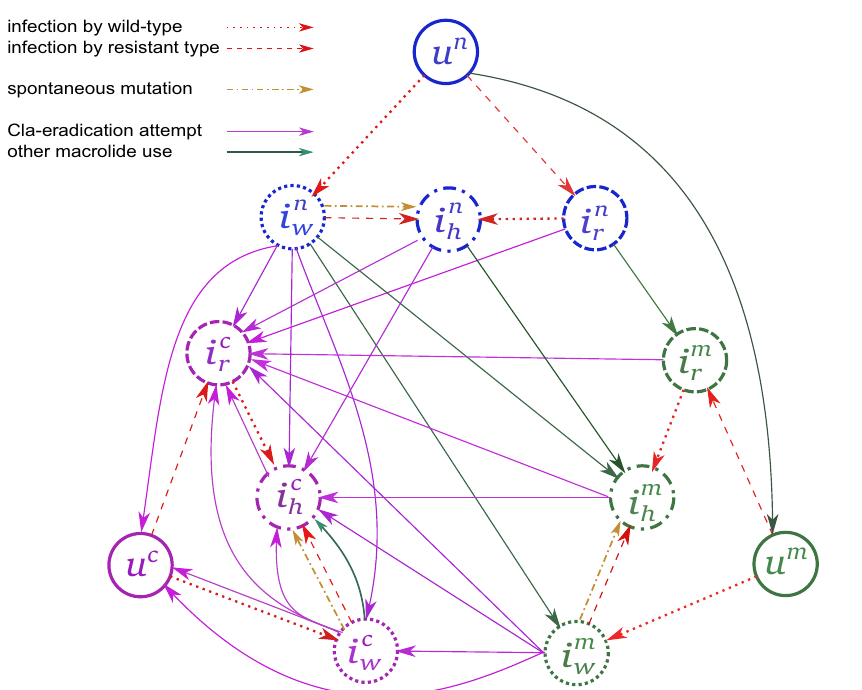
Fig. 5 Simpli fi ed transfer diagram of the mathematical model describing the transmission dynamics of clarithromycin-resistant Helicobacter pylori . Arrows indicating the transitions between the compartments: Infection with wild-type – red dotted arrow, Infection with resistant type – red dashed arrow, Spontaneous mutation – gold dashdotted arrow, Cla-eradication attempt – purple solid arrow, Other macrolide use – green solid arrow. The different compartments are indicated by the following notations: uninfected individuals as u n – macrolide-naive, u m - macrolide-exposed, u c - after Cla-containing eradication therapy, individulas with wild-type infection as i n w - macrolide-naive, i m w – macrolide-exposed, i c w – after Cla-containing eradication attempt, individuals with homoresistant infection: i n r – macrolide-naive, i m r – macrolide-exposed, i c r – after Cla-containing eradication attempt, individuals